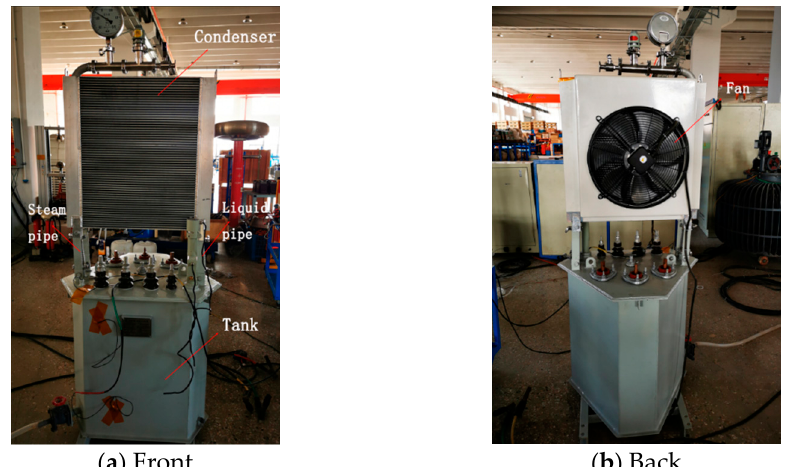
Figure 10. Prototype of evaporative cooling transformer for mine tunnels. The short circuit method is used to test the temperature rise of evaporative cooling transformer. The steady state temperature rise test results of Table 5 show that the top oil temperature rise and the average winding temperature rise are 23.9 °C and 61 °C under 1.26